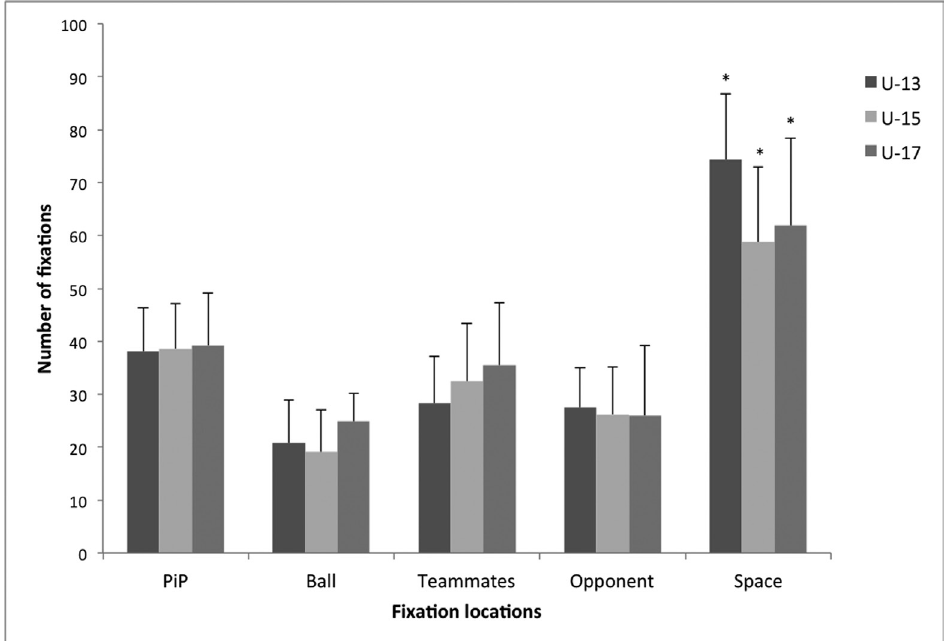
Figure 2. Means and standard deviation for the time of fixations made by each group in pre-defined locations in the video